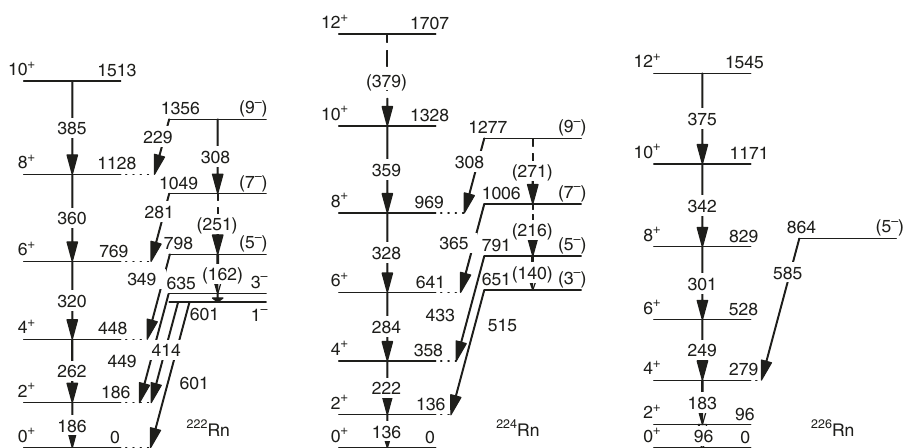
Fig. 3 Level schemes. These partial level schemes for 222,224,226 Rn show the excited states of interest. Arrows indicate γ -ray transitions. All energies are in keV. Firm placements of transitions in the scheme are from previous work 20 or have been made using γ - γ -coincidence relations; otherwise in brackets